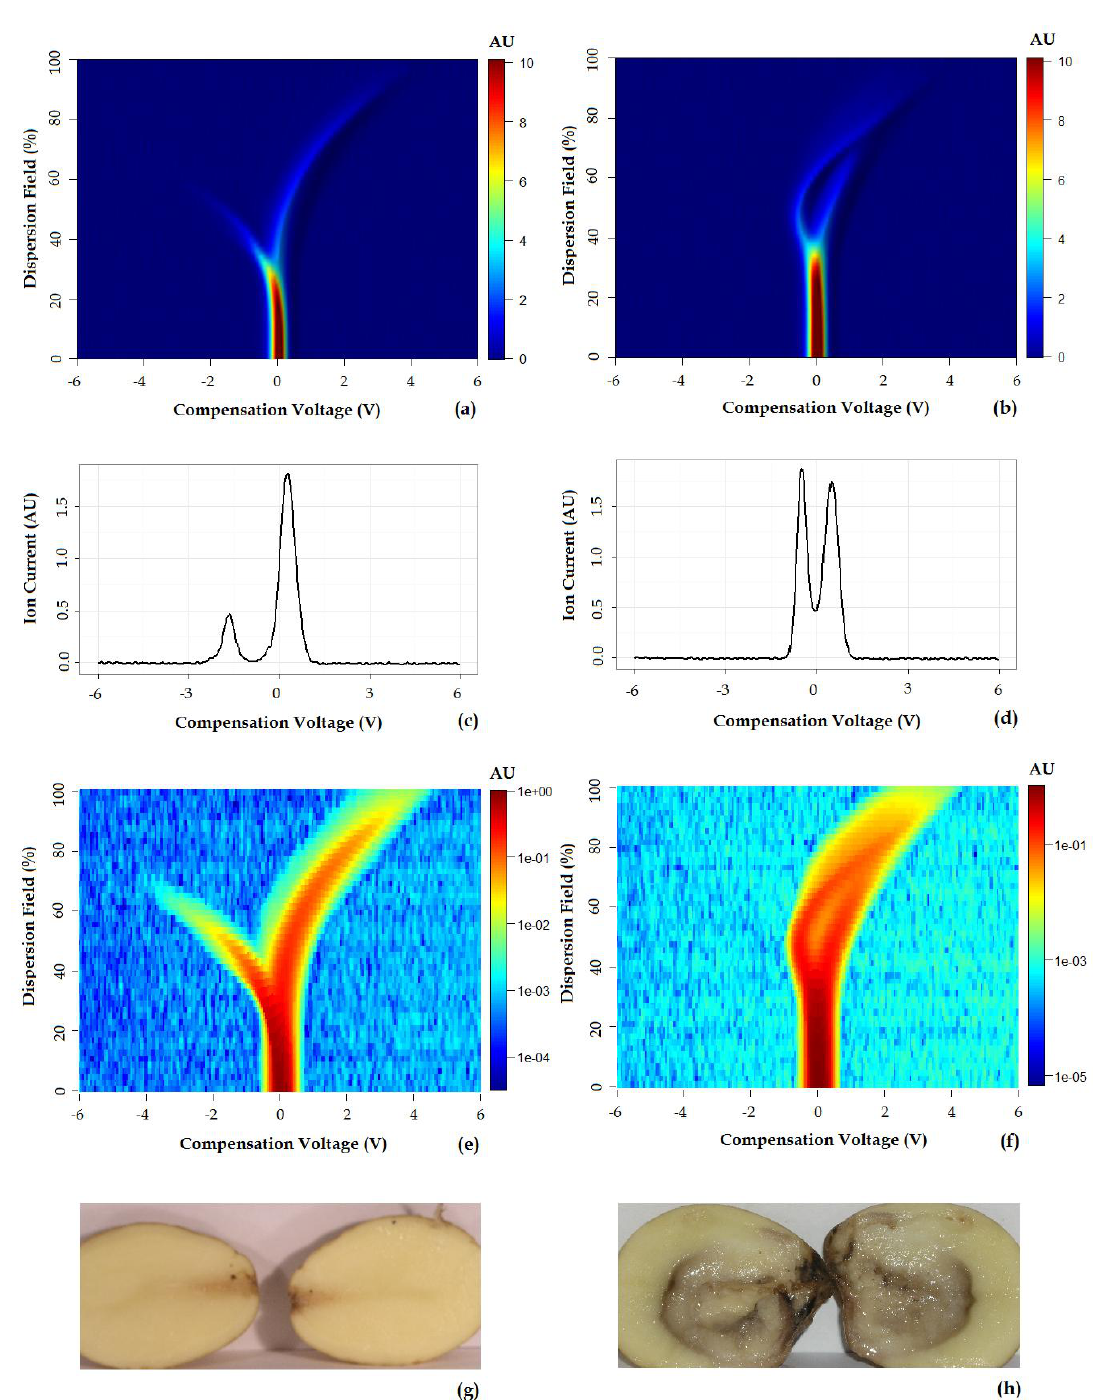
Figure 2. Control ( a , c , e , and g ) and tuber infected with soft rot ( b , d , f , h ). ( a ) and ( b ) are positive ion matrices while ( c ) and ( d ) show ion currents at 45% DF. ( e ) is the logarithmic representation on the ion current axis of ( a ), for control and ( f ) for the infected tuber in ( b ). Photographic analysis for control ( g ) and infected potato ( h